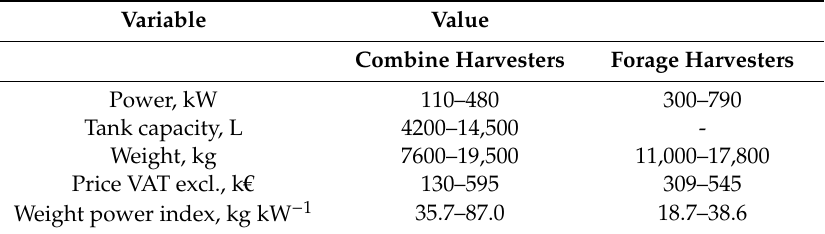
Table 2. The range for minimum and maximum values of the considered variables according to the dataset for combine and forage